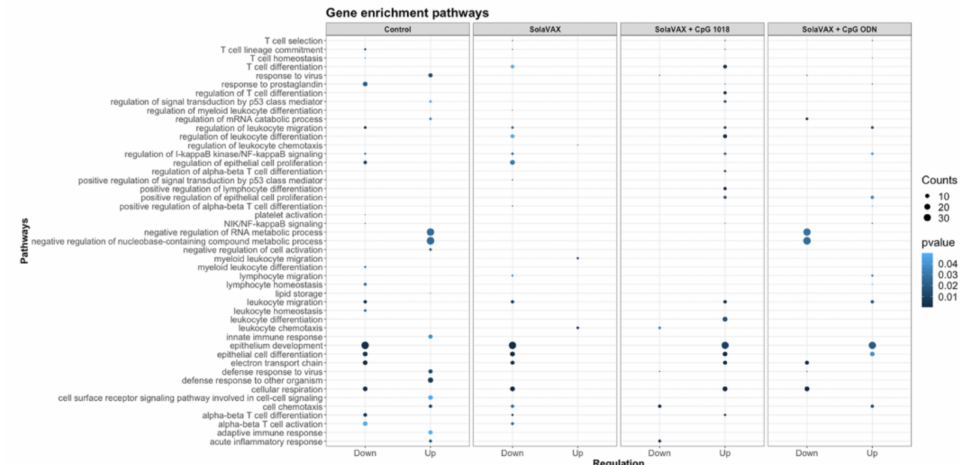
Figure 9. Enrichment p values for the selected Gene Ontology (GO) biological pathways of differentially expressed genes between Control and SolaVAX vaccinated hamsters, with or without adjuvant. Circles represent normalized enrichment score (NES), size of the circle represents the number of genes involved in the pathway and the color represents the significance score. p < 0.05 was considered